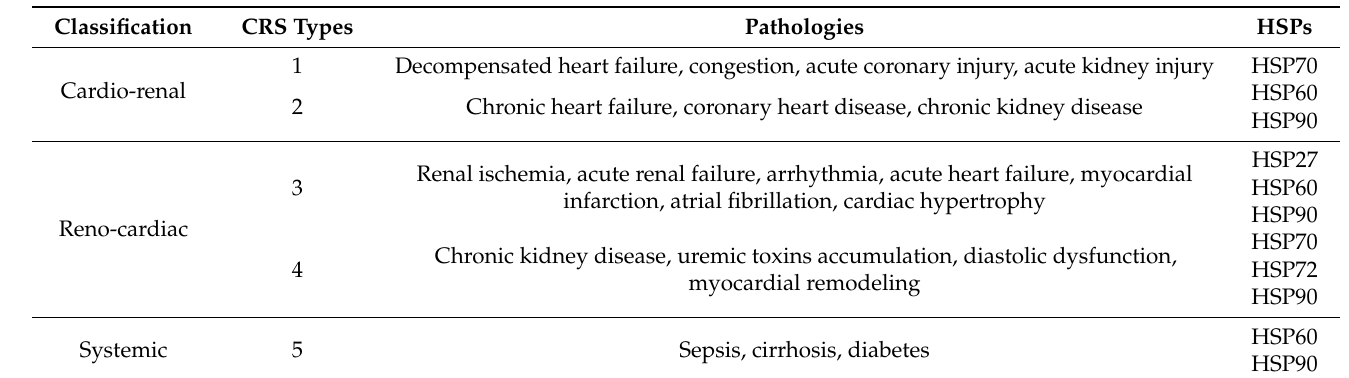
Table 1. Correlation between different types of CRS and HSP-mediated cardiovascular